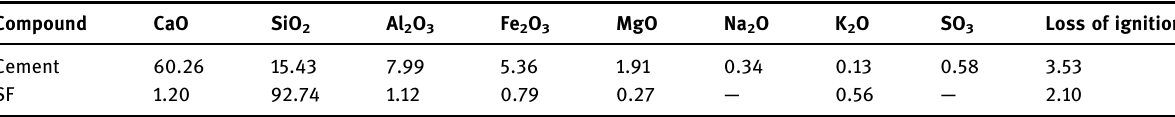
Table 1: Chemical compositions of the cement and SF ( wt% )